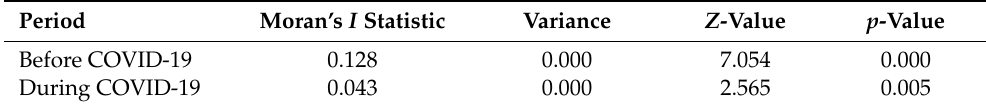
Table 5. Moran’s Tests for WTPEP before and during